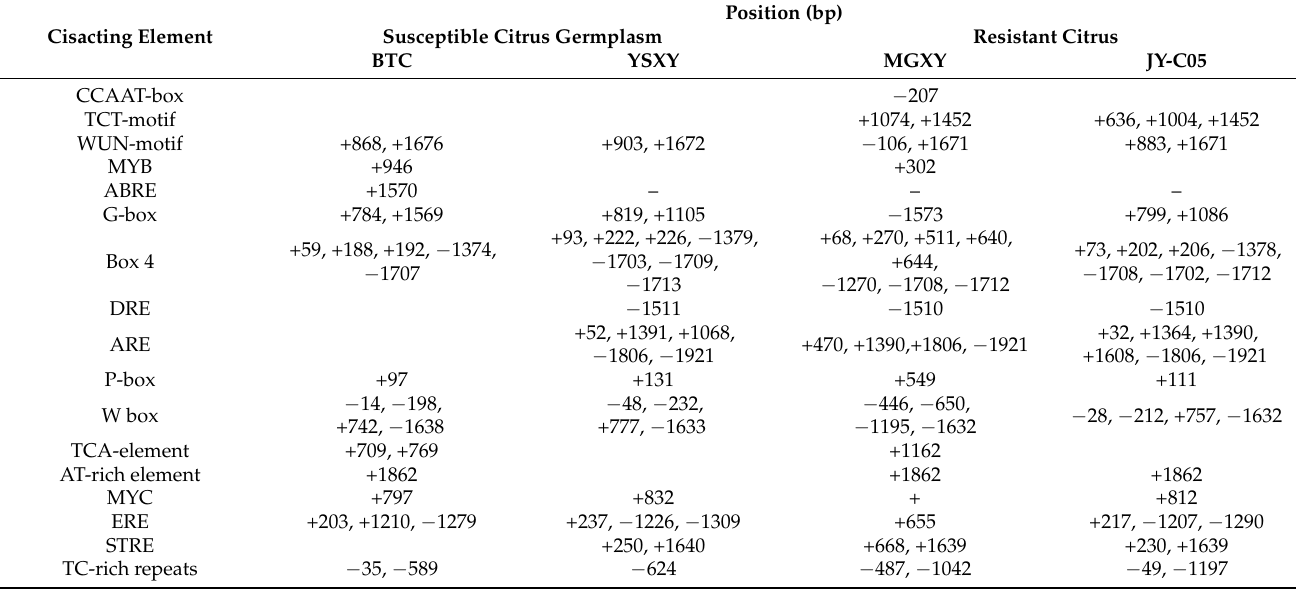
Table 7. Cis-acting elements and functions of the BAK1 promoter. BTC: ‘Bingtang’ sweet orange; YSJY: Wild citron; MGJY: American citron; JY C-05: Citron C-05.